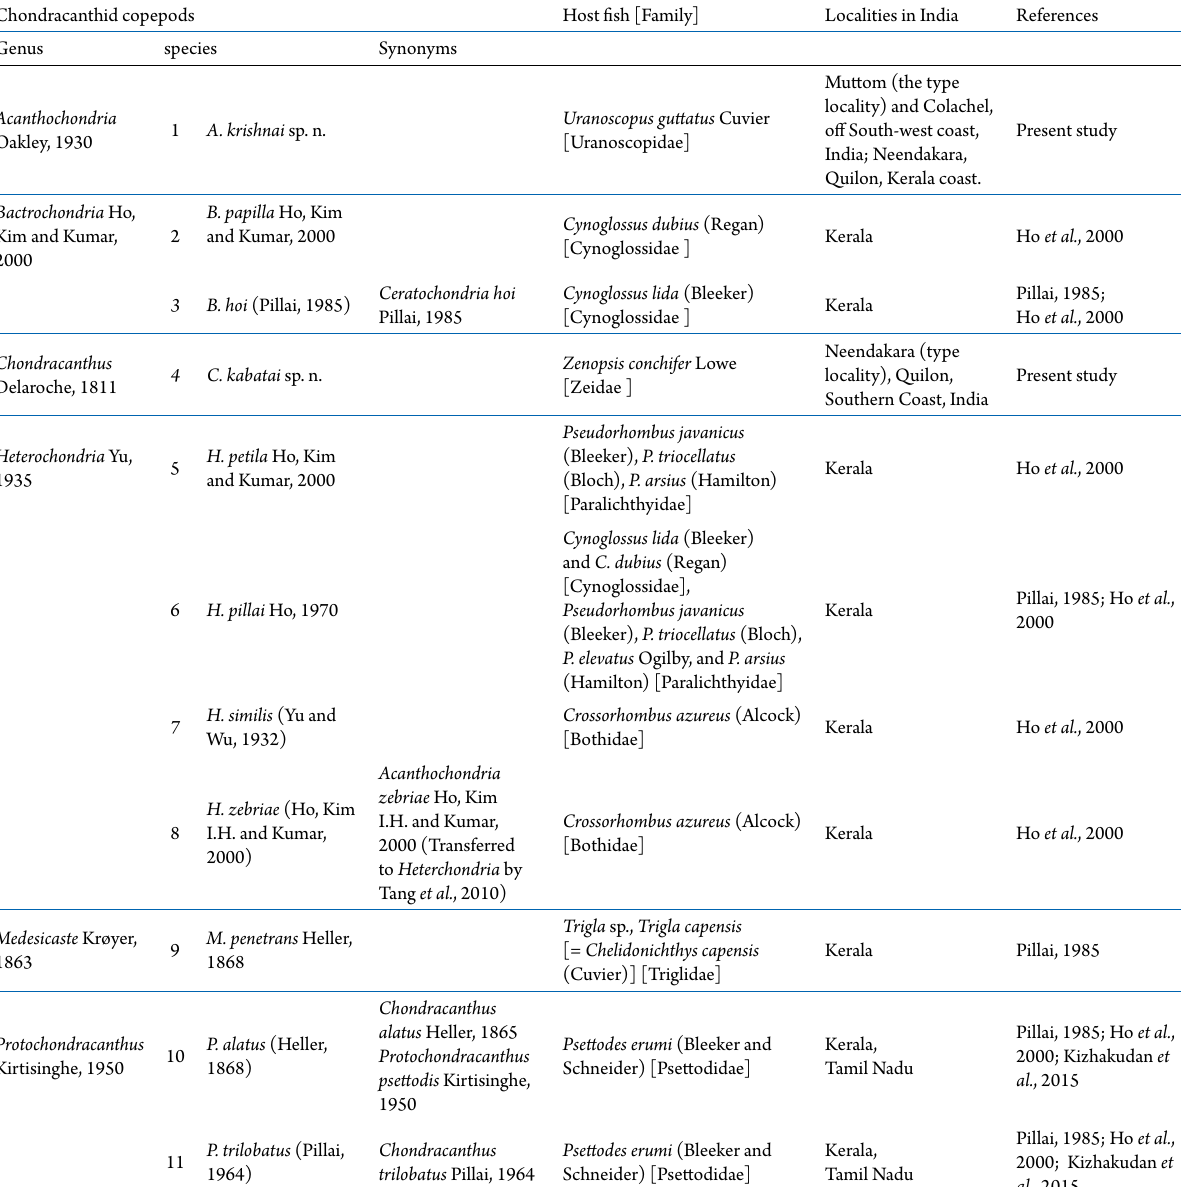
Table 1. List of chondracanthid copepods from India, with their fish hosts and distribution records. Chondracanthid